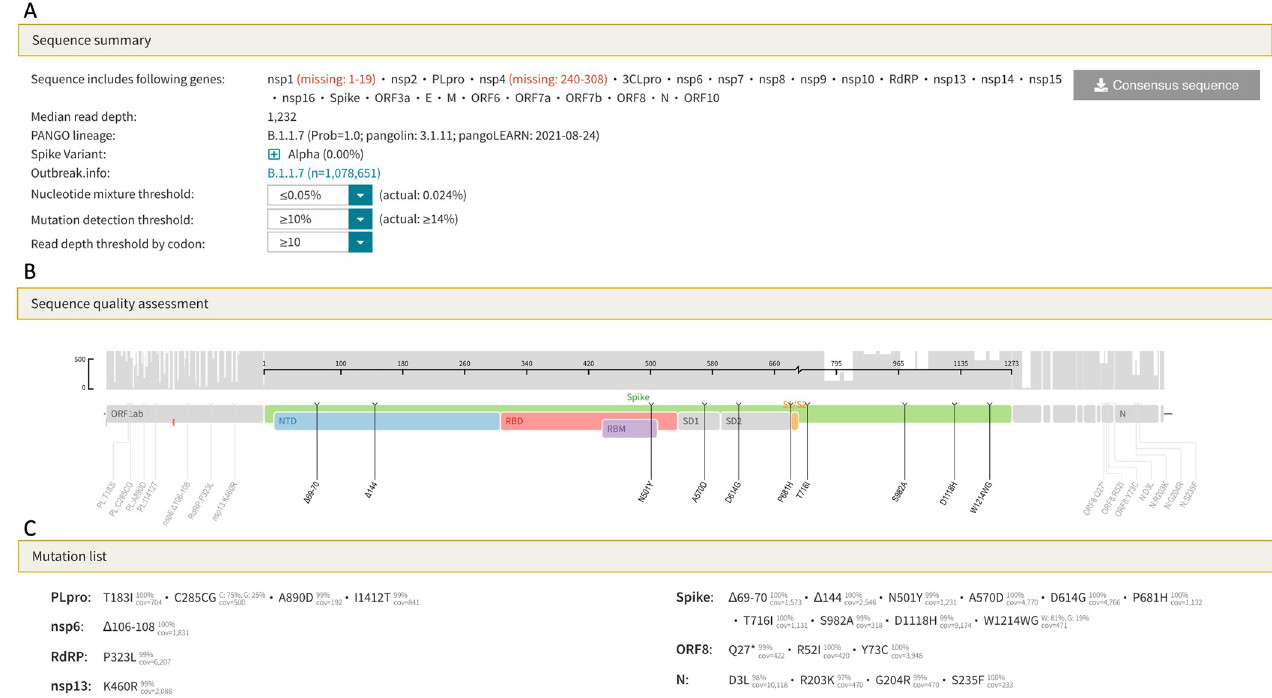
Fig 6. SARS-CoV-2 sequence analysis program output for FASTQ sequences or codon frequency tables. The sequence summary section (A) lists the genes that were sequenced, the median read depth, and the PANGO lineage. This section also contains dropdown boxes that enable the user to select the minimum number and proportion of reads, respectively, required to identify a mutation. The threshold that minimizes the proportion of positions with nucleotide ambiguities can also be selected. The sequence quality assessment section displays the read depth across the genome and lists only those amino acid mutations that meet the user-defined criteria specified in the sequence summary section (B). The mutation list section lists those amino acid mutations that meet the user- defined criteria and shows the proportion of reads containing the mutation (C). The output shown in this figure can be regenerated by loading the example file B.1.1.7 (ERR5026962) at this URL: https://covdb.stanford.edu/sierra/sars2/by-reads/.